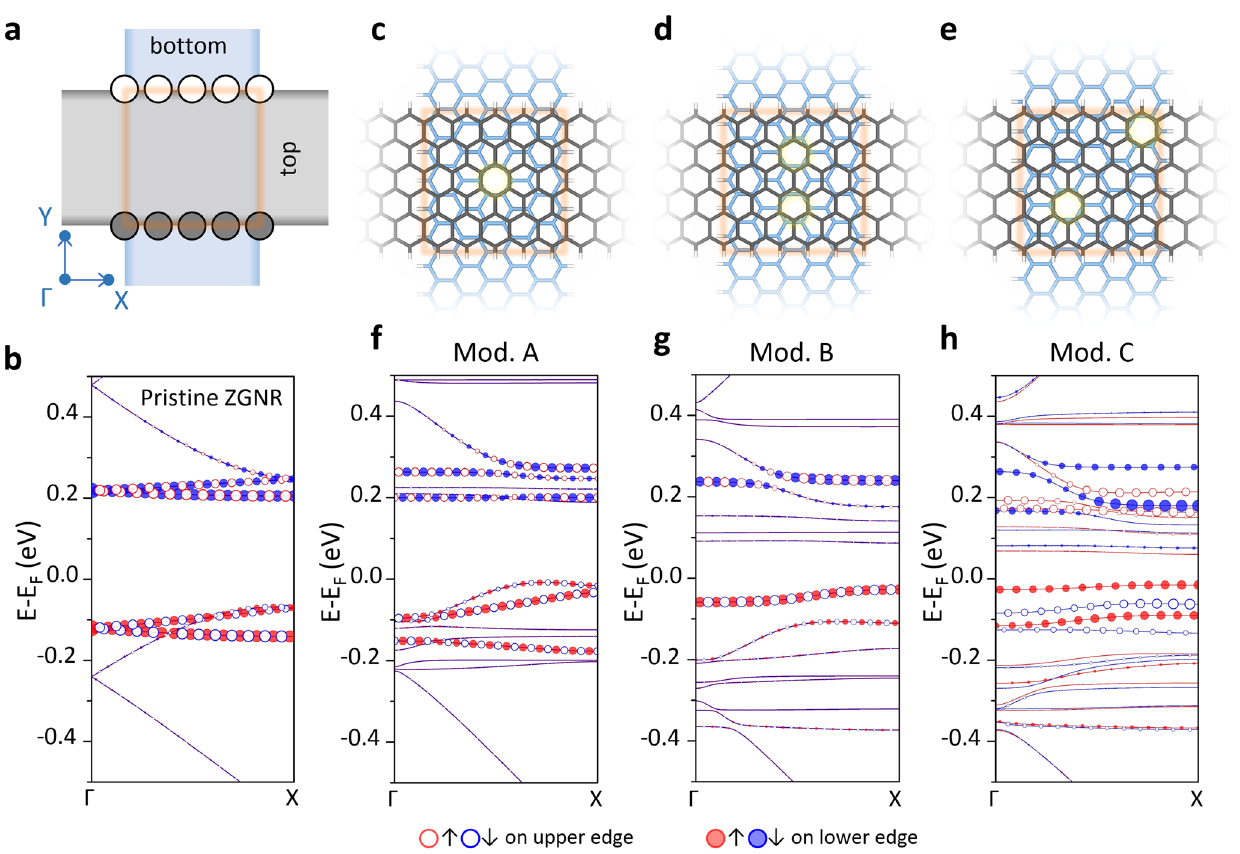
Fig.4|DFTcalculatedbandstructuresforthreedesignedTBZGNRmodelswith distinct stacking symmetries. a Illustration of the construction of TBZGNR models. Grey and blue ribbons represent the top and bottom ZGNRs, respectively. Thelightred square markstheoverlappedregion.Theopenand fi lled circlesmark the upper- and lower-edge atoms to project on, respectively. b Calculated band structures for the 11×1-supercell monolayer of pristine ZGNR. c – e Atomic